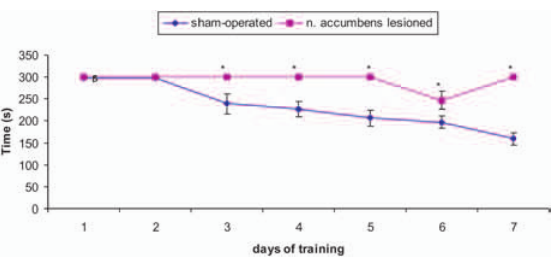
Figure 3. The time taken to consume all five baits in the rats with 6-OHDA-induced lesion of the NAcc, as studied in the radial-arm-maze task. The values are mean ± SEM (n=6 animals per group). *p<0.05 vs. sham-operated group.